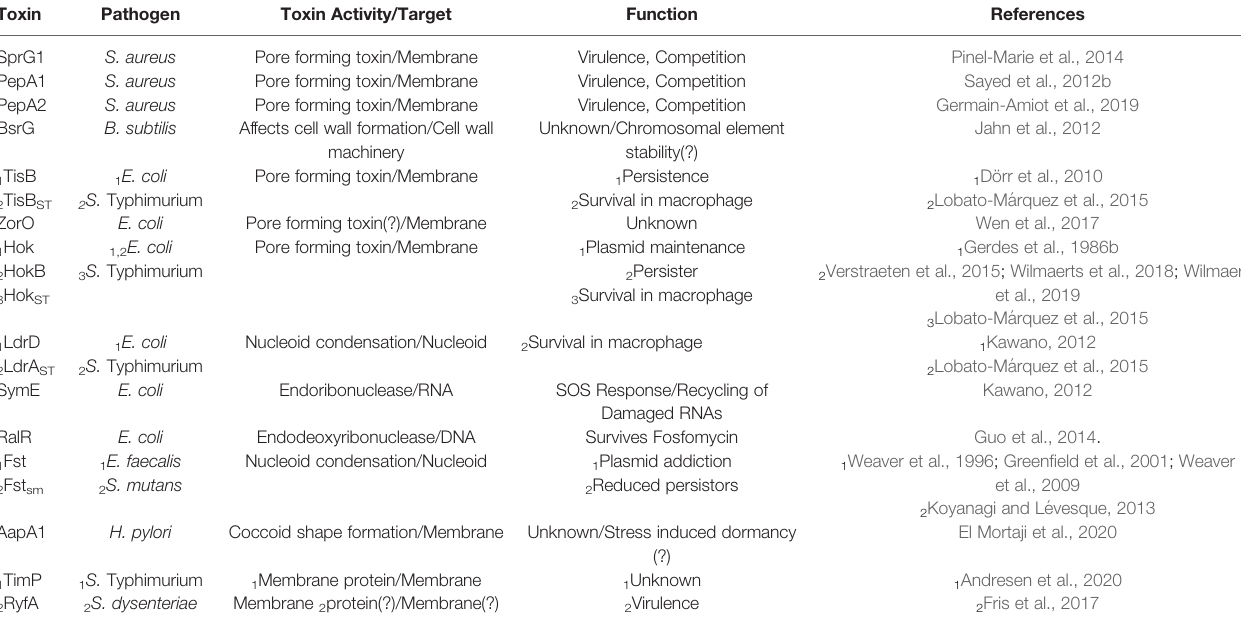
TABLE 1 | Summary of the activity, target and function of select toxins produced by Type I and Type III TA systems in pathogenic bacteria.